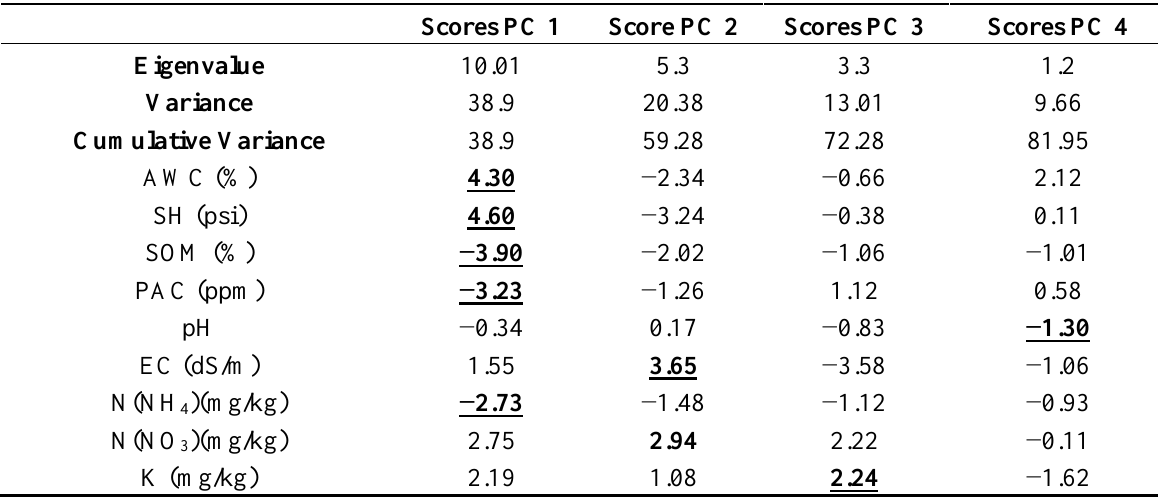
Table 6. Results of the principal component (PC) analysis of soil properties in the Schäfertal site, Germany. Bold and underlined values indicate underlined factors corresponding to the indicators included in the indices.